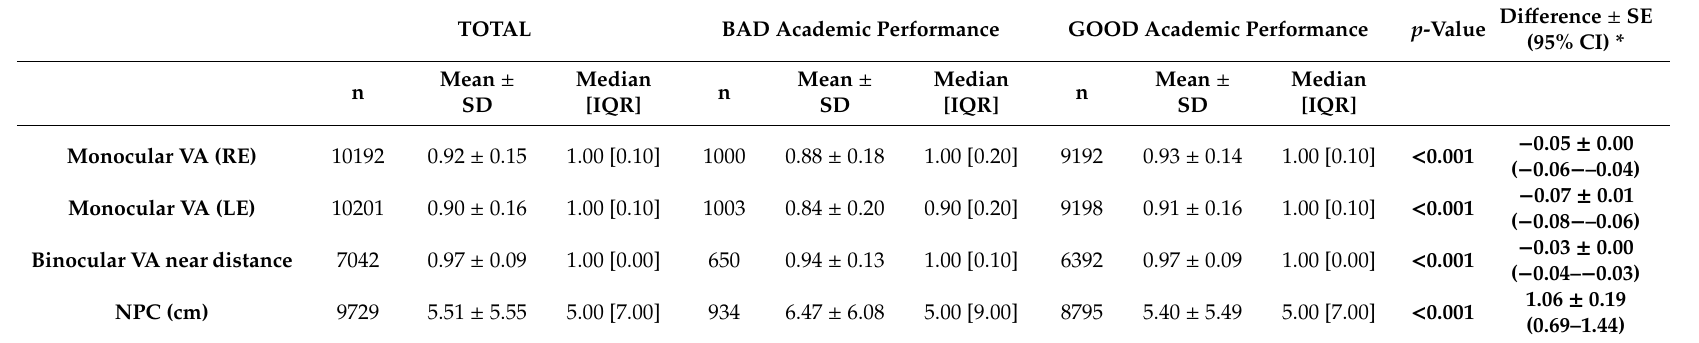
Table 4. Results from visual